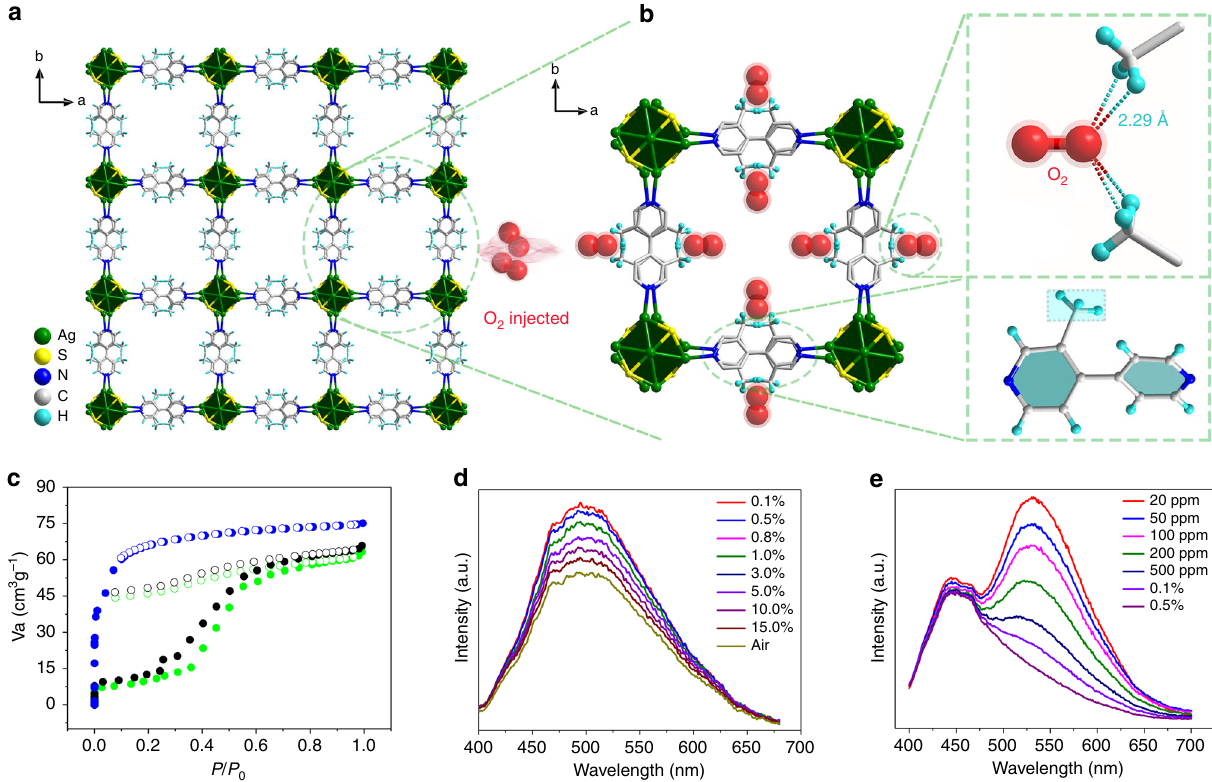
Fig. 4 The oxygen molecule position in Ag 12 bpy-CH 3 and the oxygen-sensing performance. a Channels of Ag 12 bpy-CH 3 and b O 2 -inclusion of Ag 12 bpy- CH 3 ·O 2 , as viewed along the c -axis. The most preferable positions of the oxygen molecules are displayed. The smallest separation between O 2 and the − CH 3 groups (O···H) is equal to 2.29 Å. Color code: Ag, green; S, yellow; C, gray; N, blue; H, light turquoise; O, red. The H atoms of bpy and − t Bu groups of the host backbone are omitted for clarity. c N 2 adsorption/desorption isotherms of Ag 12 bpy-NH 2 (blue line), Ag 12 bpy-CH 3 (green line) and Ag 12 bpy-NH 2 / CH 3 (1:100) (black line) at 77 K. d Oxygen-dependent emission intensity of Ag 12 bpy-CH 3 in the range of 0.1% to ambient air conditions. e Oxygen- dependent dual-emission intensity of Ag 12 bpy-NH 2 /CH 3 (1:100) in the range of 20 ppm to